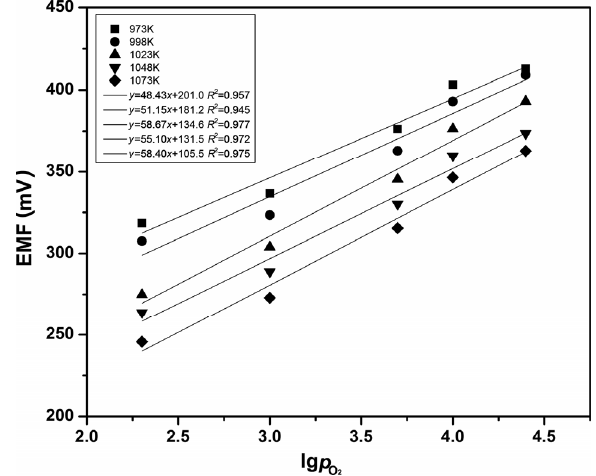
Fig. 1 Setup used to determine the oxygen content of molten